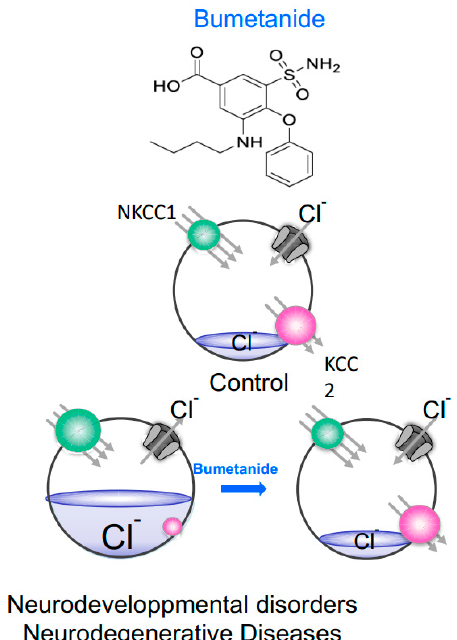
Figure 2. Neurons under control conditions, neurodevelopmental disorders and/or neurodegenerative diseases. In control mature neurons, the activity of KCC2 (red) dominates over NKCC1 (green) and intracellular Cl − is actively kept low. When the GABA receptor (grey) is activated, Cl − enters the cell, which hyperpolarizes the membrane. In neurodevelopmental disorder or neurodegenerative disease, NKCC1 function is stimulated whereas KCC2 function is diminished and as a result, intracellular Cl − increases returning the neuron to an immature state with depolarizing GABA responses. In these cases, bumetanide by inhibiting NKCC1 facilitates the return to low Cl − concentrations.